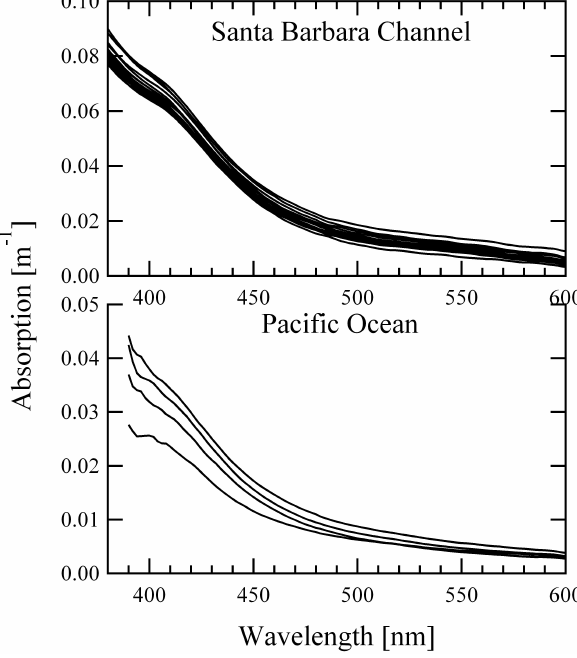
Fig. 5. Light absorption of CDOM from subsurface depths (80–200m) of samples from (a) the Santa Barbara Channel (California, Northeast Pacific) and (b) from offshore of New Caledonia (West